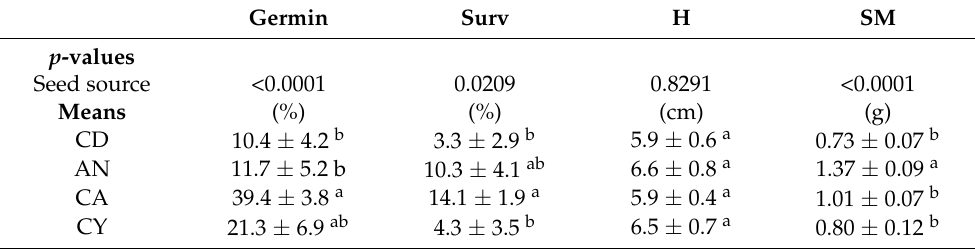
Table 1. p -values from the analysis of variance and means per seed sources (plus standard errors) for germination (Germin), survival (Surv), height (H), and seed mass (SM) on C. alba in the laboratory experiment. Seed sources were Cuesta La Dormida (CD), Antumapu (AN), Cantillana (CA) and Cayumanque (CY). Different letters within a column indicate significant differences according to Tukey’s test. Germin Surv H SM p -values Seed source <0.0001 0.0209 0.8291